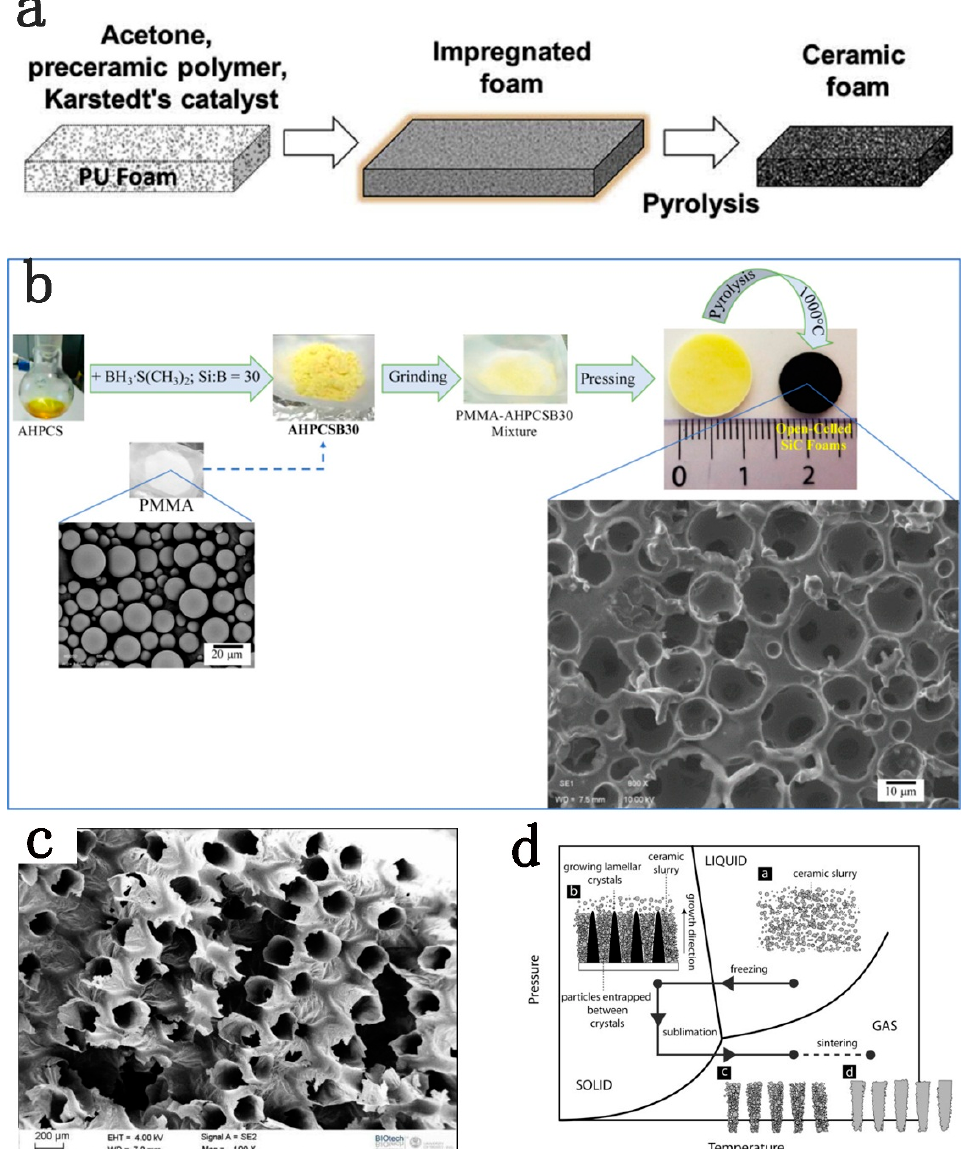
Figure 3. Schematic of impregnating polyurethane (PU) foam with precursor solution to prepare porous SiCN(O) and SiOC mesh foams ( a ); schematic of preparing high-porosity open-cell SiC foam with polymethyl methacrylate (PMMA) beams as pore-forming agent ( b ); hollow SiOC ceramic filaments ( c ); three steps of freeze casting ( d ) [8,46,64,68]. ( a ) reproduced with permission from Santhosh B., Ceram. Int.; published by Elsevier, 2020. ( b ) reproduced with permission from Santhosh B., J. Eur. Ceram. Soc.; published by Elsevier, 2019. ( c ) reproduced with permission from Kulkarni A., Addit. Manuf.; published by Elsevier, 2020. ( d ) reproduced with permission from Sylvain D., Adv. Eng. Mater.; published by Wiley, 2008.